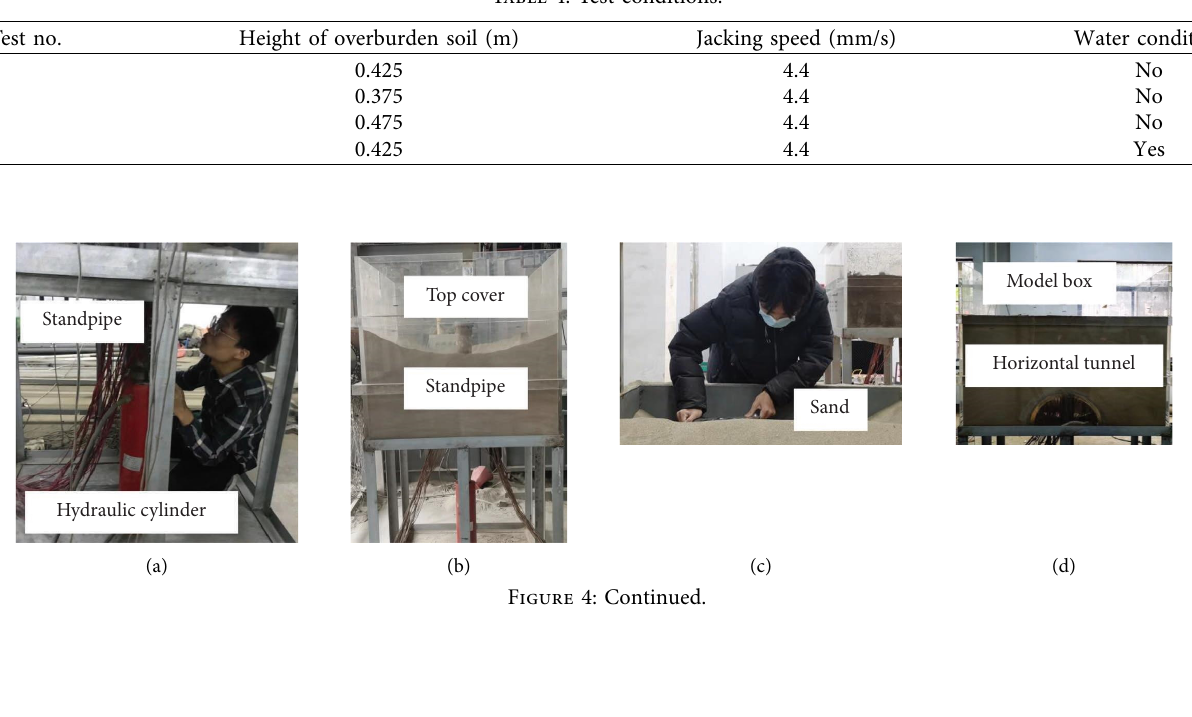
Table 4: Test conditions.